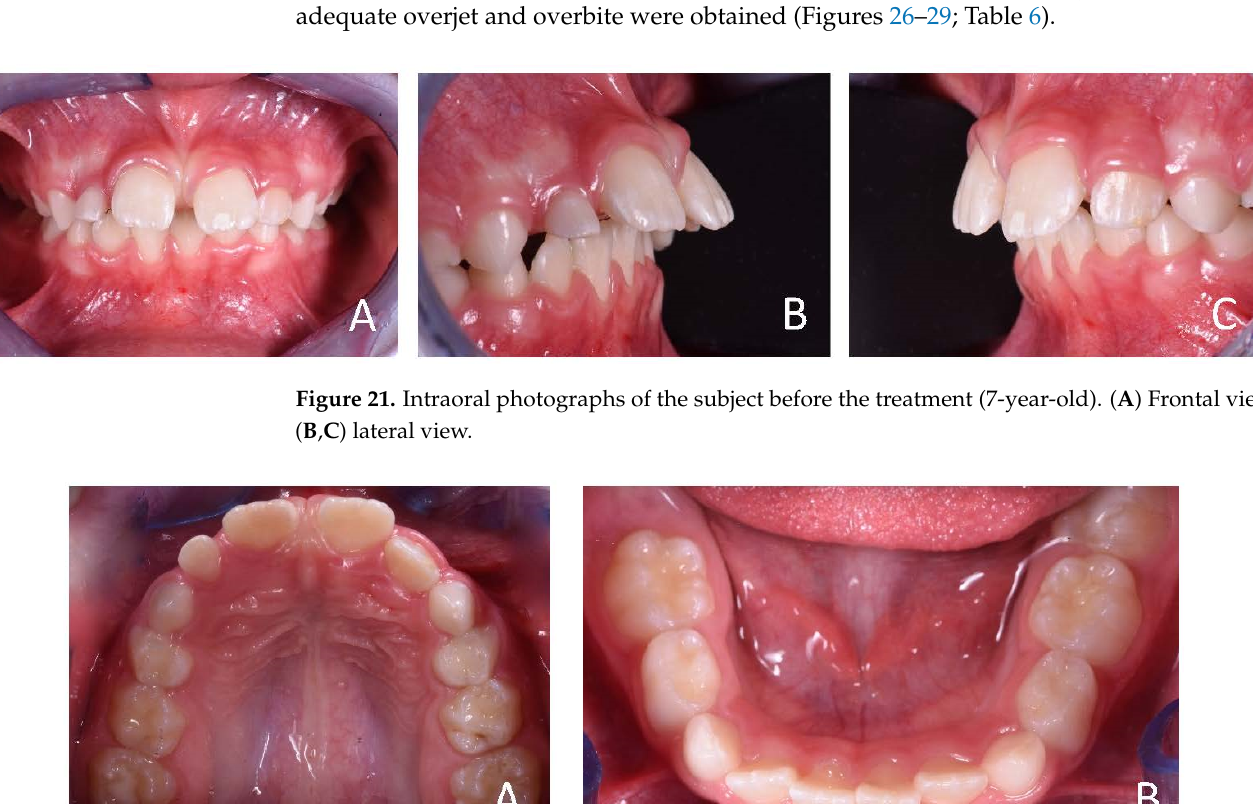
Figure 23. Radiographs of the patient at the screening. Orthopantomography X-ray before treatment (7-year-old).